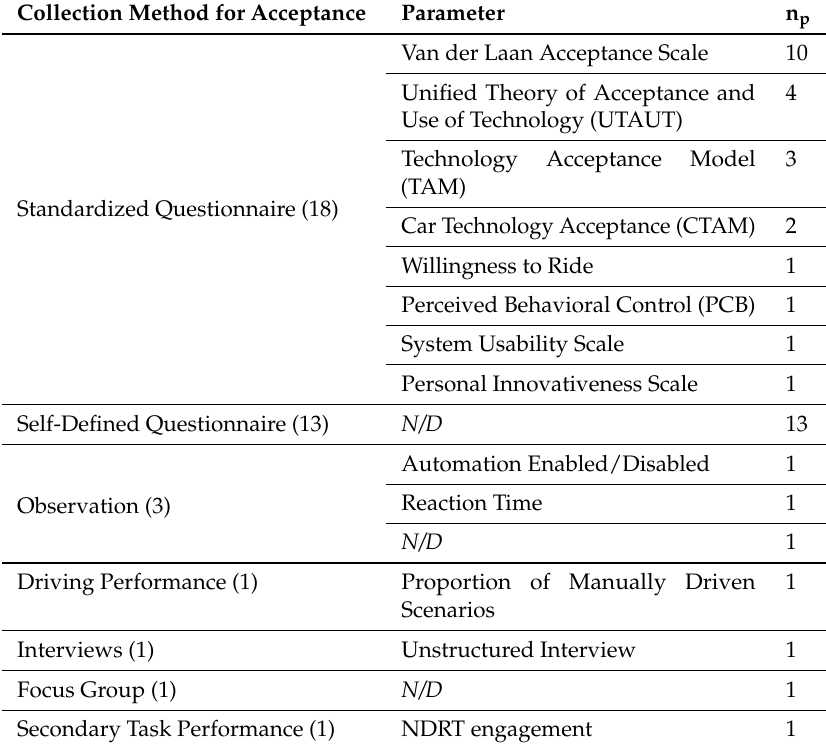
Table 4. Acceptance collection methods and parameters.